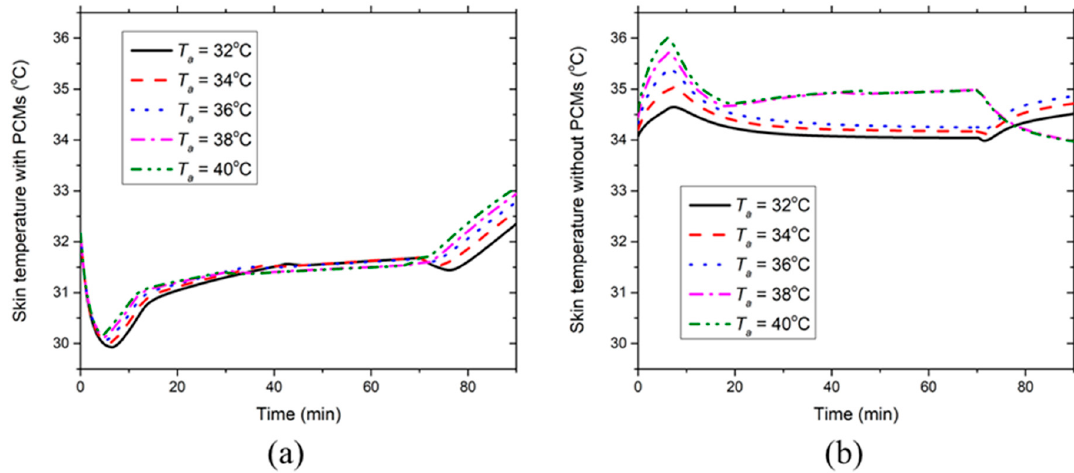
Figure 5. Effect of environmental temperature on the time course of chest skin temperatures ( a ) with and ( b ) without PCMs and insulation layers at RH = 50%.